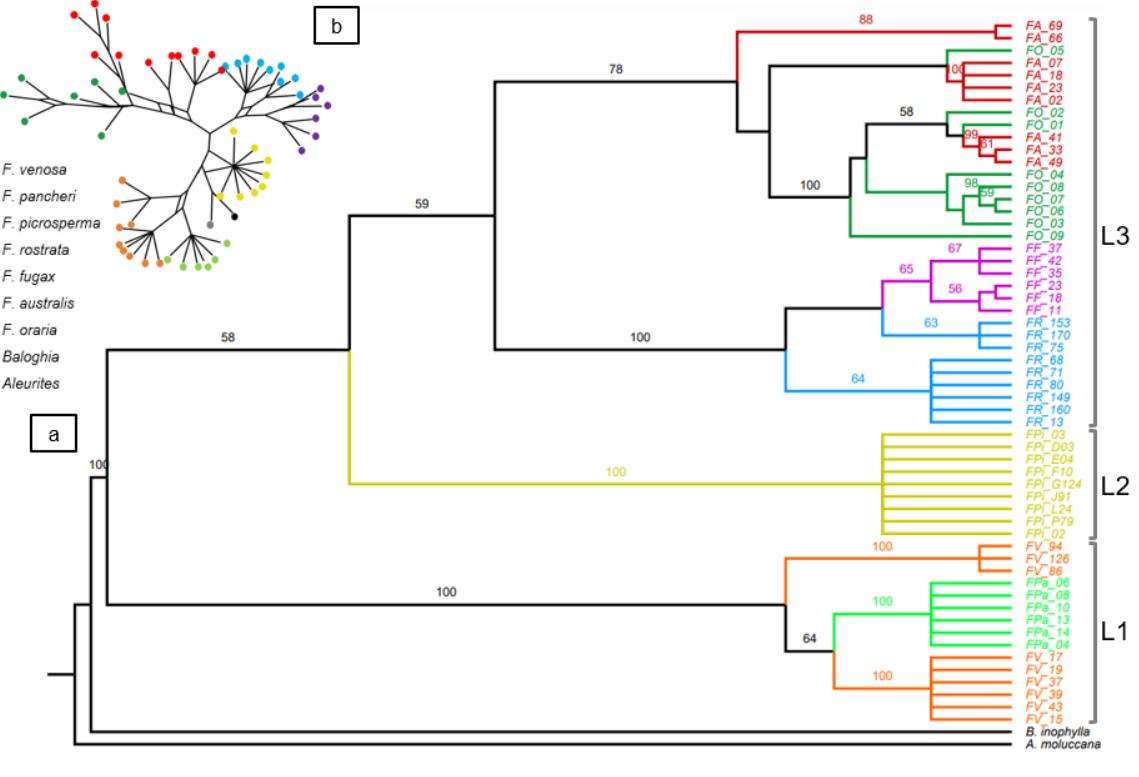
Figure 2. Phylogenetic tree with proportional terminal nodes ( a ) and consensus network ( b ) of the Austral-Pacific Fontainea complex constructed from individually aligned and concatenated cpDNA sequence markers using a maximum-likelihood analysis. Baloghia inophylla and Aleurites moluccana were used as outgroup representatives to root the tree. The values on the phylogenetic tree at the branches represent bootstrap support (>50) based on the best-fit GTR + G + I model, and the scale bar represents substitutions per site. The three Fontainea lineages recovered (L1, L2, L3) are represented outside the tip labels of the tree. Tree and consensus network tips are coloured by species; see inset legend.